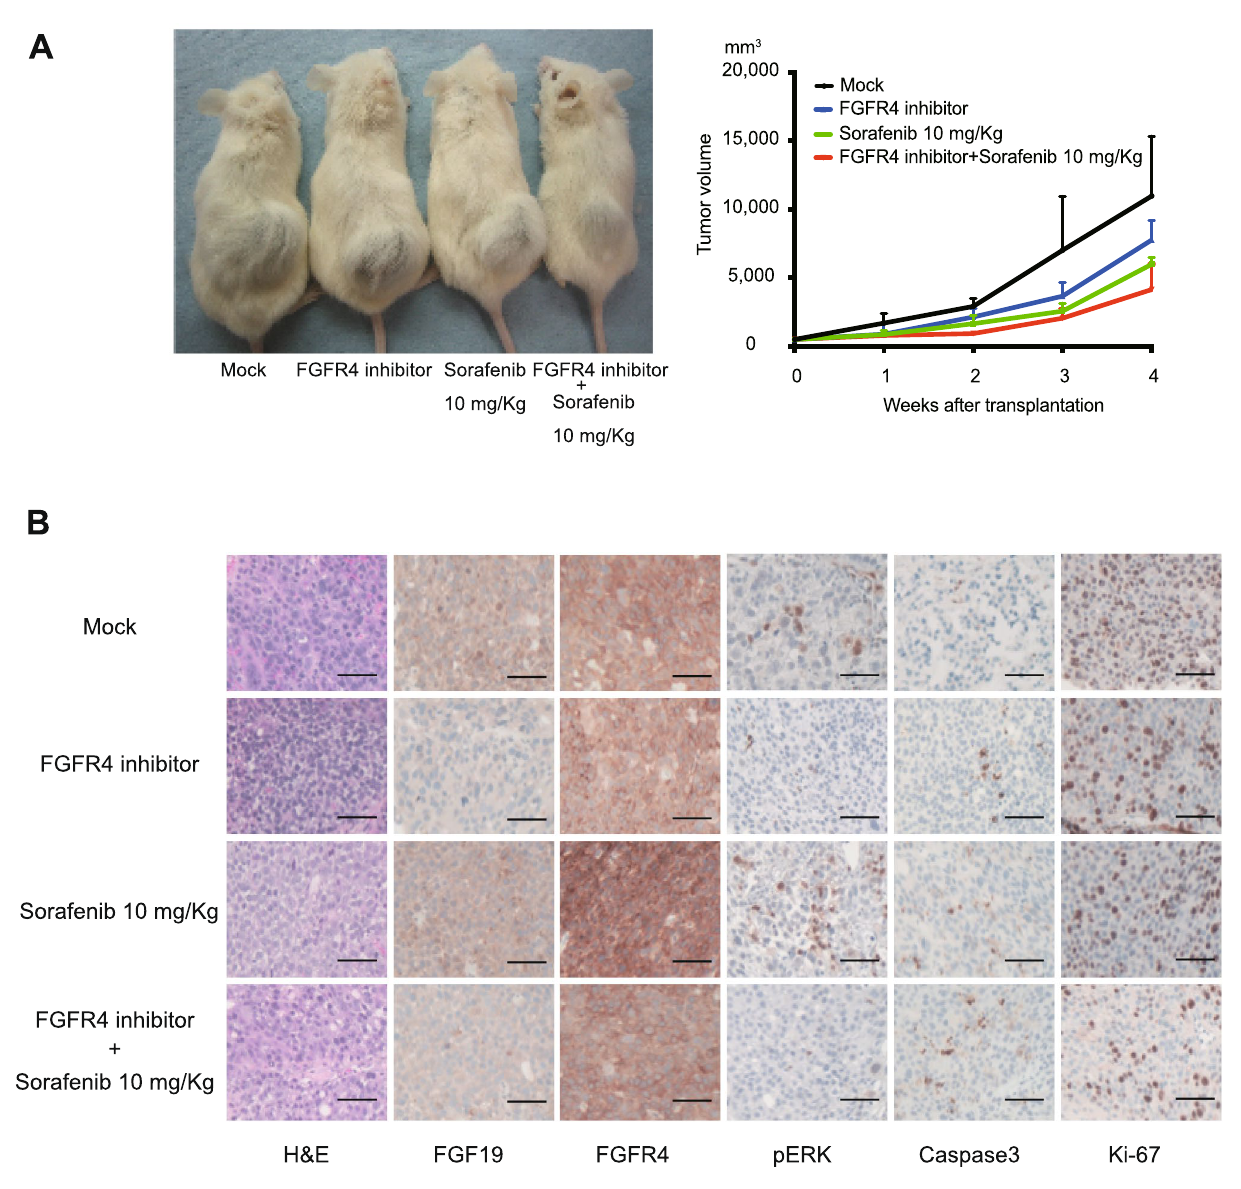
Figure 4. Xenograft transplantation and immunohistochemical analyses of NOD/SCID mice. ( A ) A total of 2 × 10 6 Huh7 cells were transplanted into the subcutaneous areas of NOD/SCID mice. Representative images of recipient mice treated with FGFR4 inhibitor (30 mg/Kg) and/or sorafenib (10 mg/Kg) 4 weeks after transplantation (left panel). The tumor volume was monitored weekly after cell transplantation (right panel). ( B ) Hematoxylin and eosin (H&E) staining and immunohistochemical analyses of subcutaneous tumors. Scale bar = 100